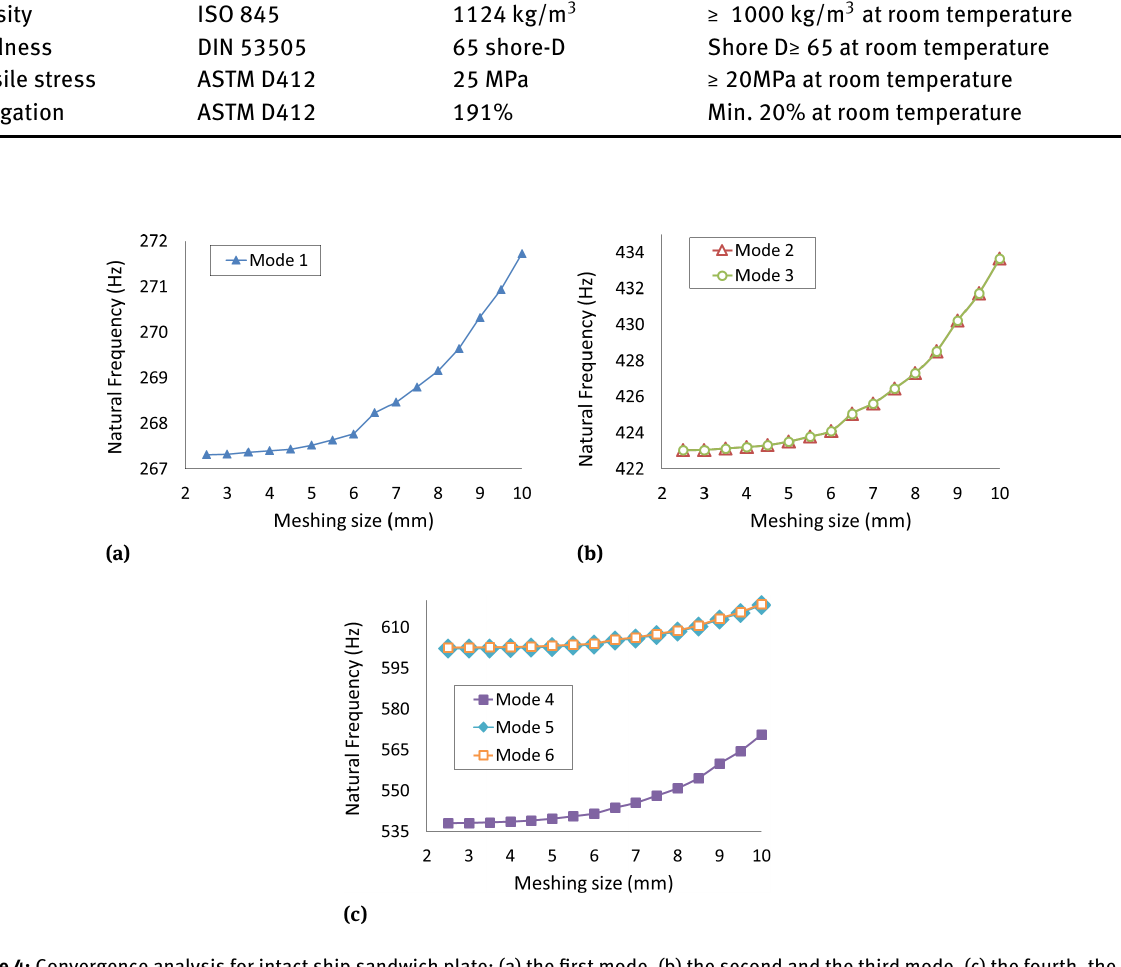
Figure 4: Convergence analysis for intact ship sandwich plate: (a) the first mode, (b) the second and the third mode, (c) the fourth, the fifth, and the sixth mode